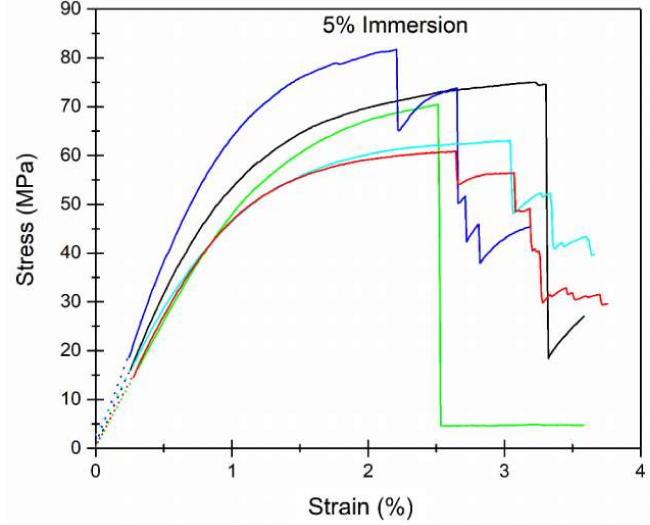
Figure 8. Stress (MPa) vs. strain (%) curves obtained by three-point bending tests for the sample of Fir wood immersed in a 5% PVBVA solution (note: see the Electronic supplementary material for other